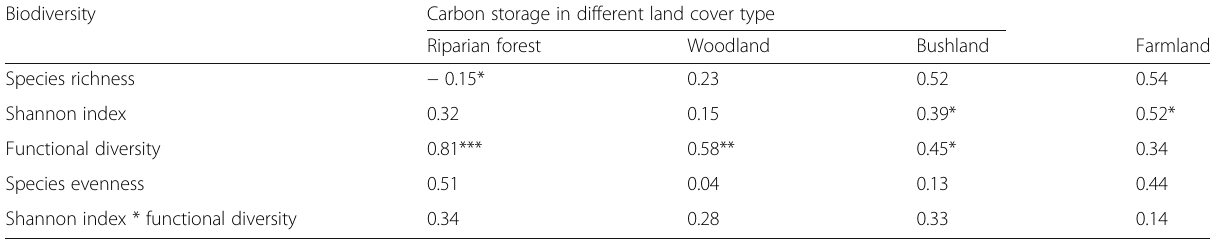
Table 4 Pearson correlations ( r ) and generalized linear mixed models to test the relationships between carbon storage with species richness, functional diversity, species dominance, and functional dominance in different land cover types in Eastern Ethiopia